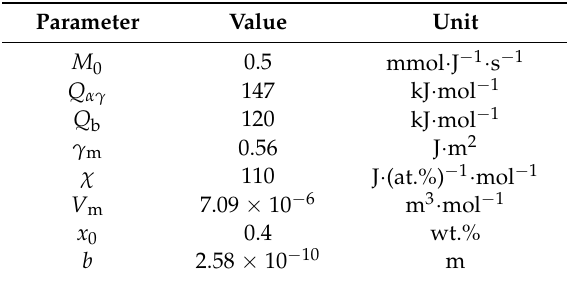
Table 1. Key parameters used in the simulations [42,48,58].